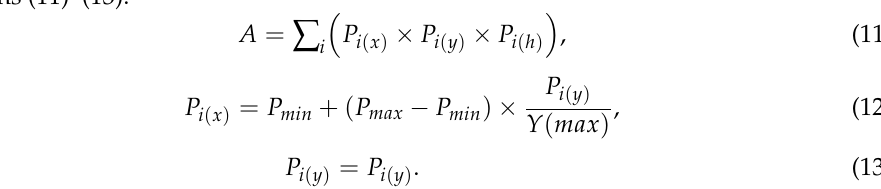
Table 2. Volume measurement result of load.